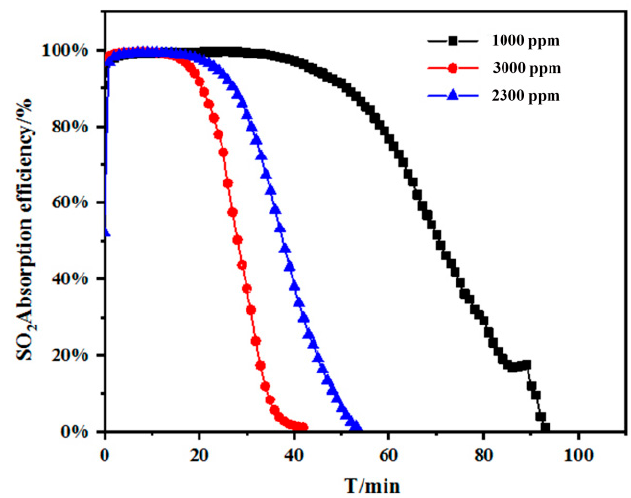
Figure 6. Effect of SO 2 concentration on desulfurization efficiency. Gas flow = 1.68 L/min, absorption solution = 60 mL, Ci-Na = 0.06 mol/L and HA–Na = 0.2 g and 25 ° C.